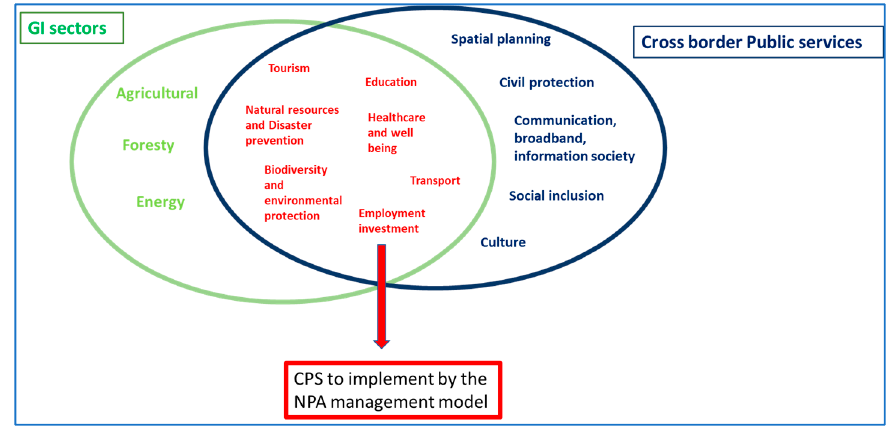
Figure 4. CPS to implement by the NPA management model. Source: Elaborated by the Autor. GI: green